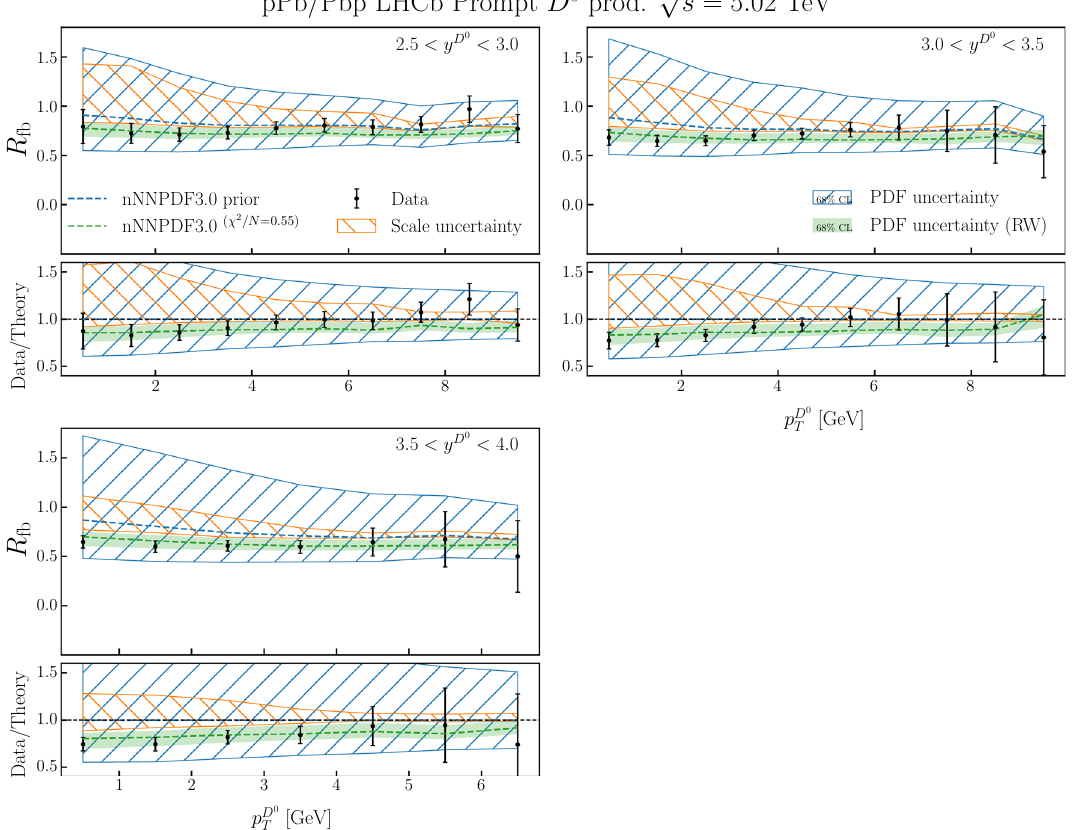
Fig. 26 Same as Fig. 7 now for the case in which the LHCb data on the forward-to-backward ratio R fb defined in Eq. (2.4) is added to the prior set by reweighting